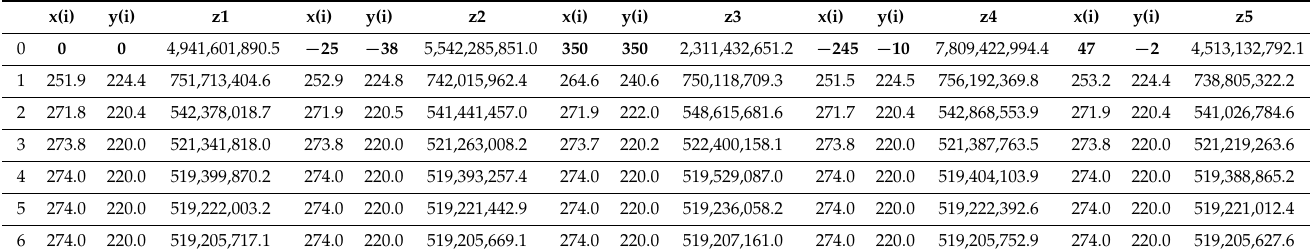
Table 5. Iteration procedure for calculating the optimal position of the distribution centre for different